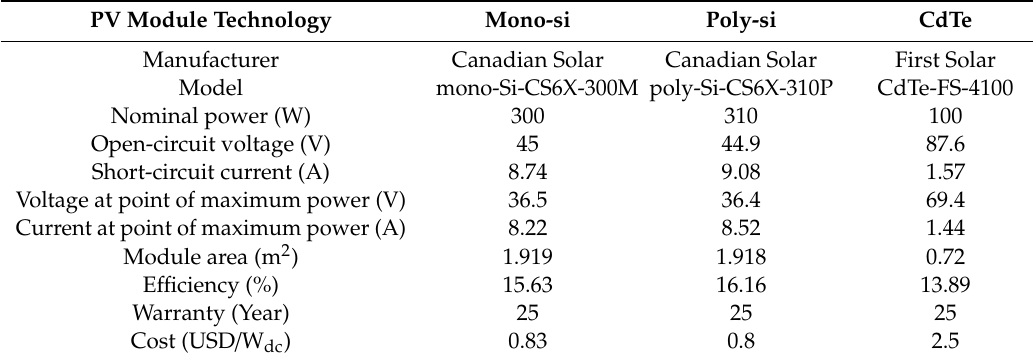
Table 2. Technical specification of the Photovoltaic (PV)